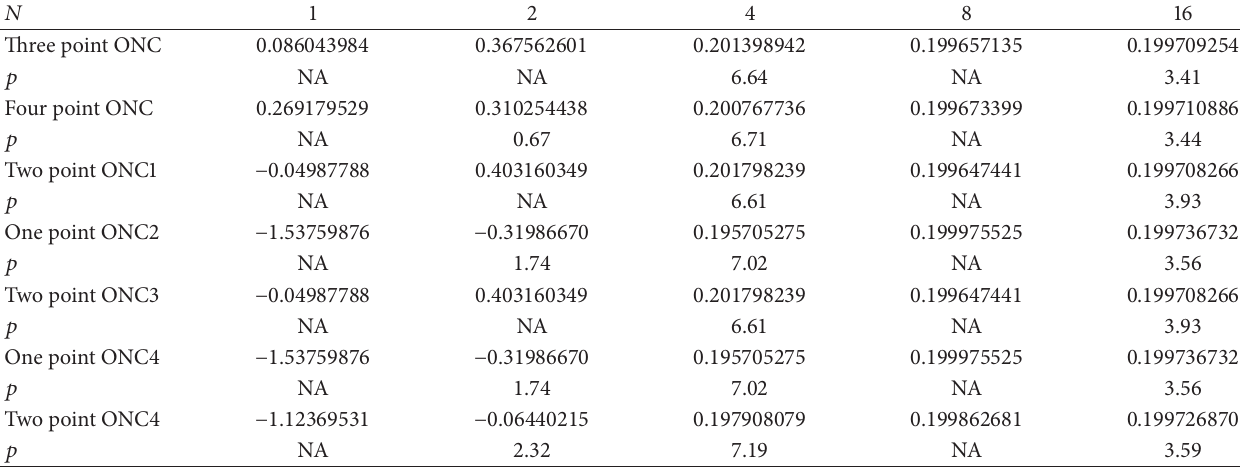
3 𝑒 −2𝑥 sin (4𝑥)𝑑𝑥 0